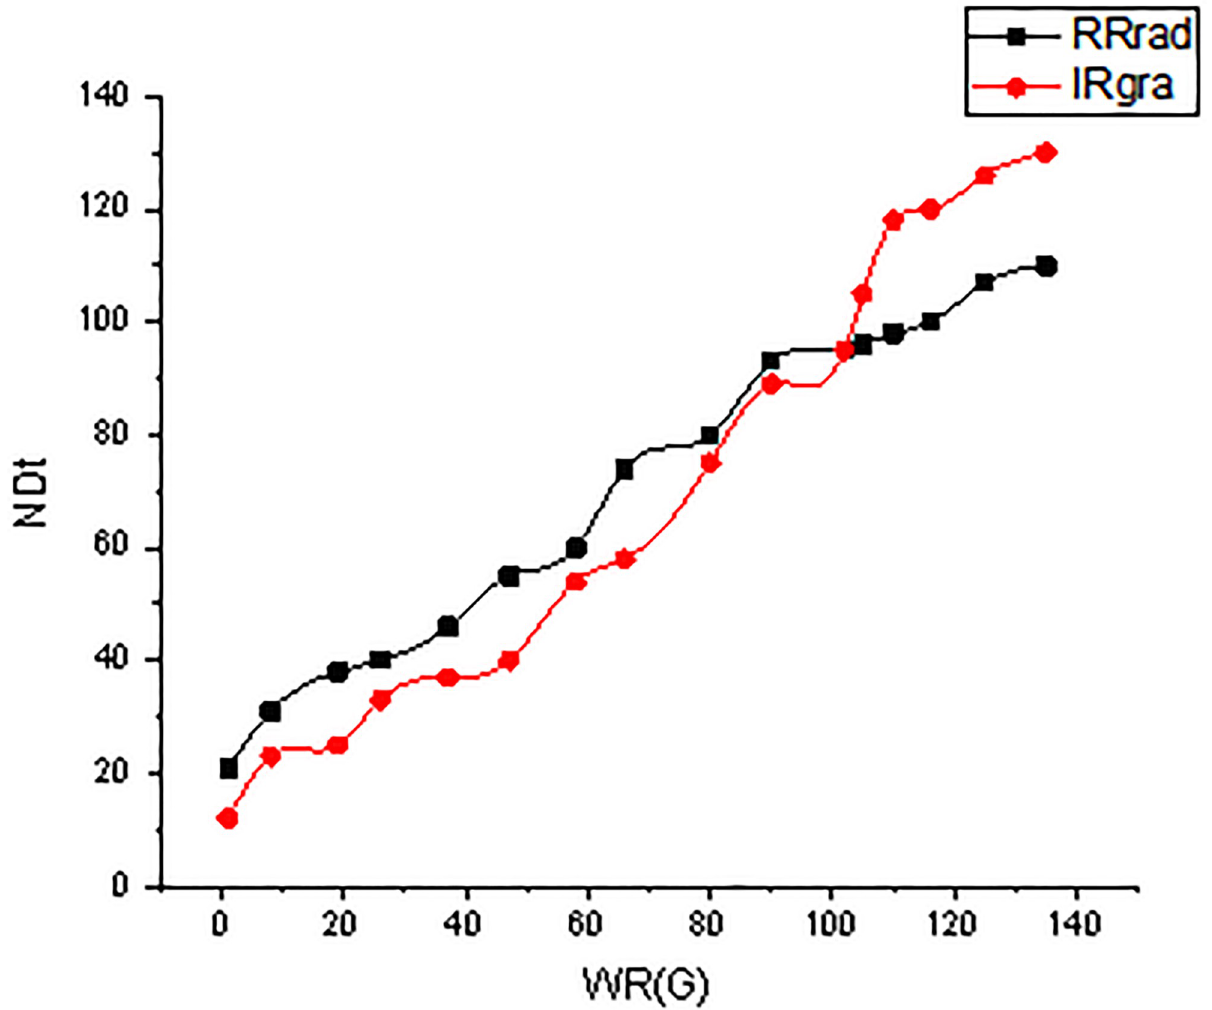
Fig 5. The change trend of new dynamic energy of manufacturing enterprises in the second stage with different levels of change.